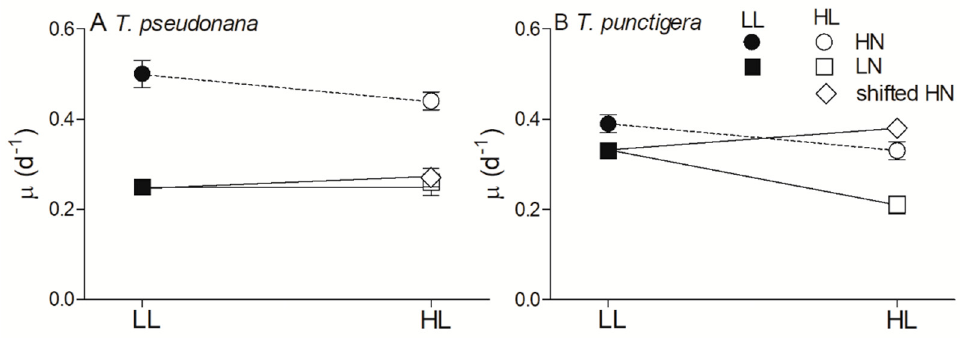
Figure 2. Growth rate ( μ , day − 1 ) of small Thalassiosira pseudonana ( A ) and large T. punctigera ( B ) grown under low (35 μ mol photons m − 2 s − 1 ) and shifted-high lights (250 μ mol photons m − 2 s − 1 ), and under low (88.2 μ M) and high/shifted-high nitrogen conditions (882 μ M). Points show the averages of three growth replicates grown on independent cultures, and error bars show the standard deviations (n = 3), often within the symbols.